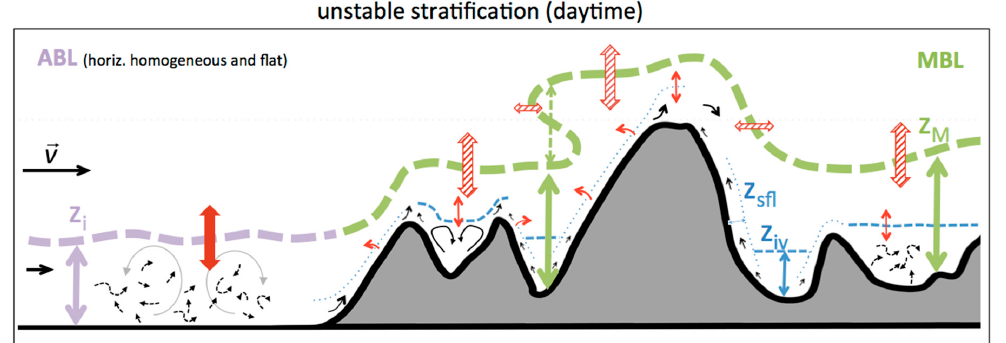
Figure 2. Sketch of exchange (red full and dashed arrows) between the free atmosphere and ( left ) the horizontally homogeneous and flat atmospheric boundary layer (ABL) and ( right ) the mountain boundary layer (MBL) for daytime (unstable stratification) under weak to moderately weak background-wind conditions. Thin red arrows indicate exchange between different sublayers of the MBL. Thick dashed lines denote the corresponding boundary layer heights (purple for the horizontally homogeneous and flat ML height z i and green for the height of the MBL z M ), while dashed and dotted blue lines denote valley-inversion heights z iv and slope-flow-layer heights z sfl , respectively. Lines are not shown where the top of a layer is unclear. Green and purple double arrows show the depths of the layers while the green dashed arrow points to the possibility of multiple heights with the same characteristics. Black solid arrows indicate thermal wind circulations (e.g., upslope flows) and black dashed arrows indicate boundary-layer turbulence. Synoptic wind is from the left. Note that not all the arrows are displayed to reduce figure complexity. The figure is inspired by the pioneering sketch of Ekhart [50] (used already in De Wekker and Kossmann [51]) and idealized simulations by Wagner et al. [49,52], Leukauf et al. [34,53], and Lang et al. [54].